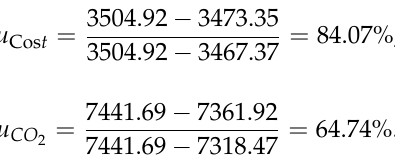
Figure 4. Optimal satisfaction levels for the model with uncertain information.